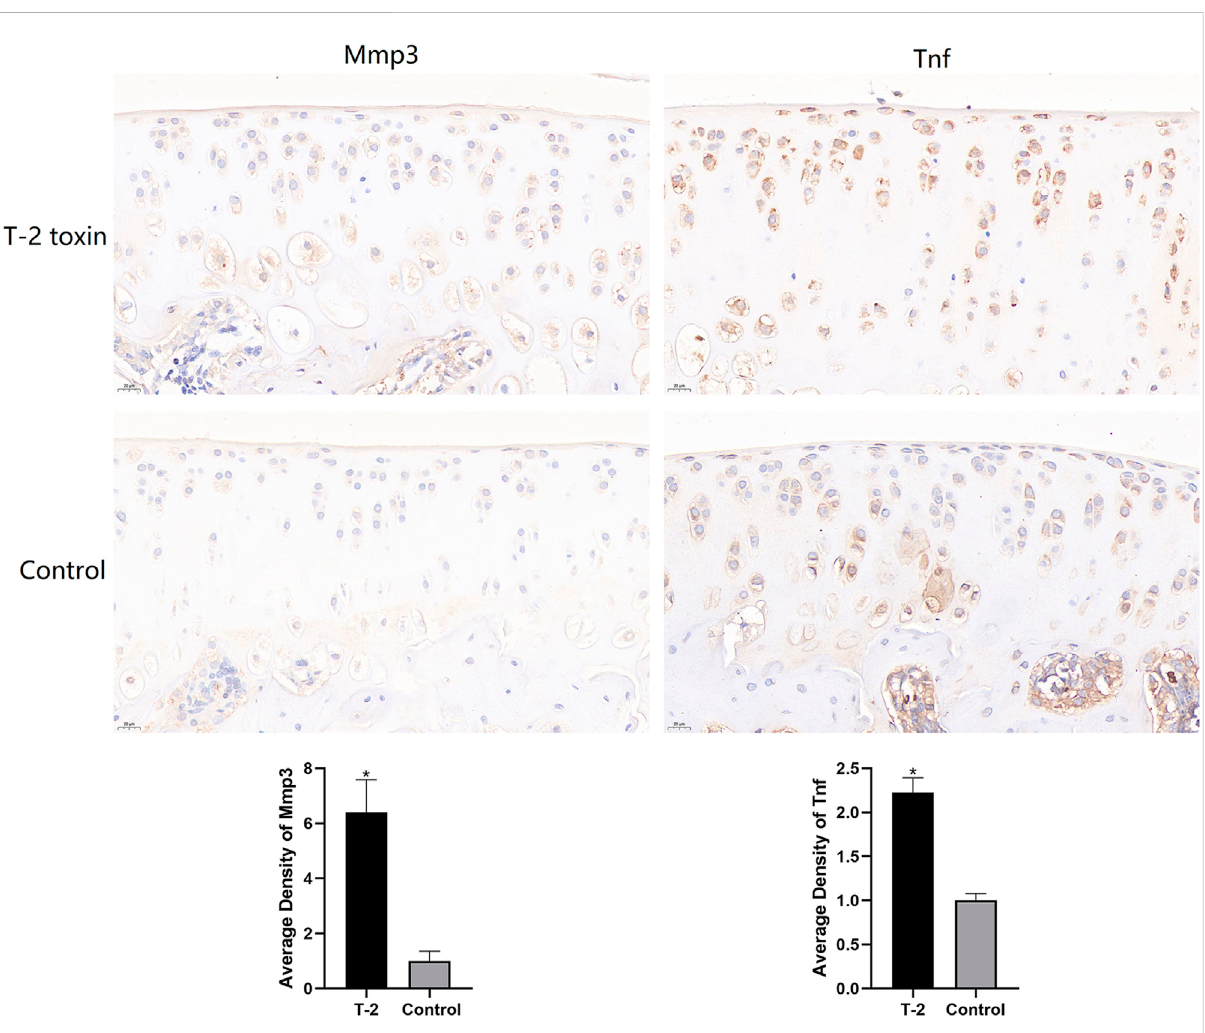
FIGURE 8 Immunohistochemistry staining of knee joint cartilage of rats in the T-2 toxin and control groups. All data represent mean ± SD, and * p < 0.05 was considered signi fi